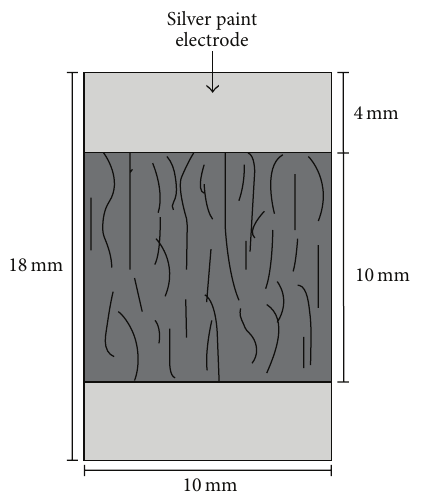
Figure 2: MWCNT/PSF specimen for electrical characterization.